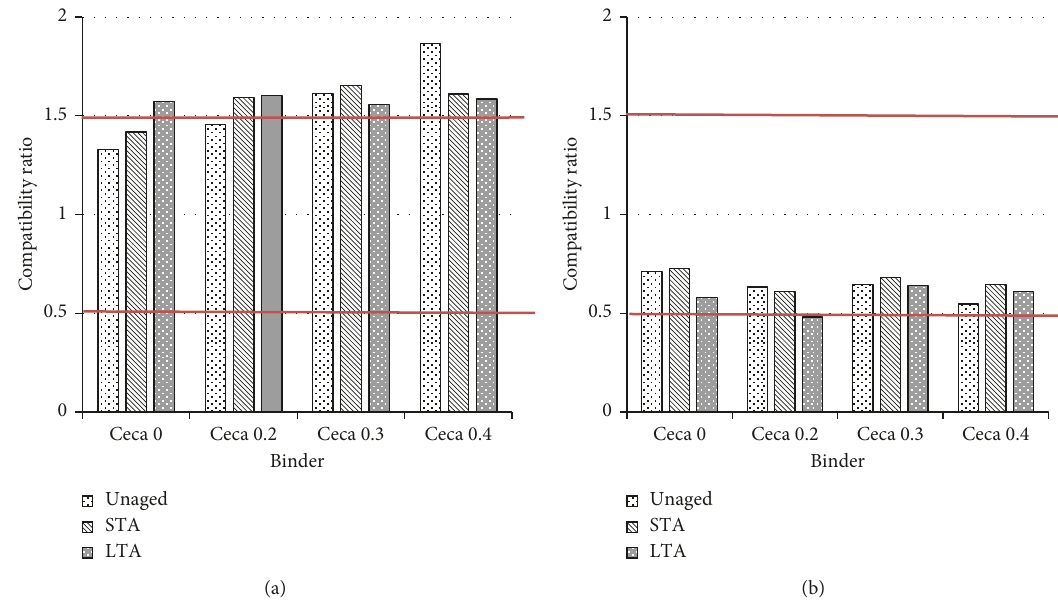
Figure 12: Compatibility ratio of PG-64 asphalt binder: (a) limestone; (b) granite.